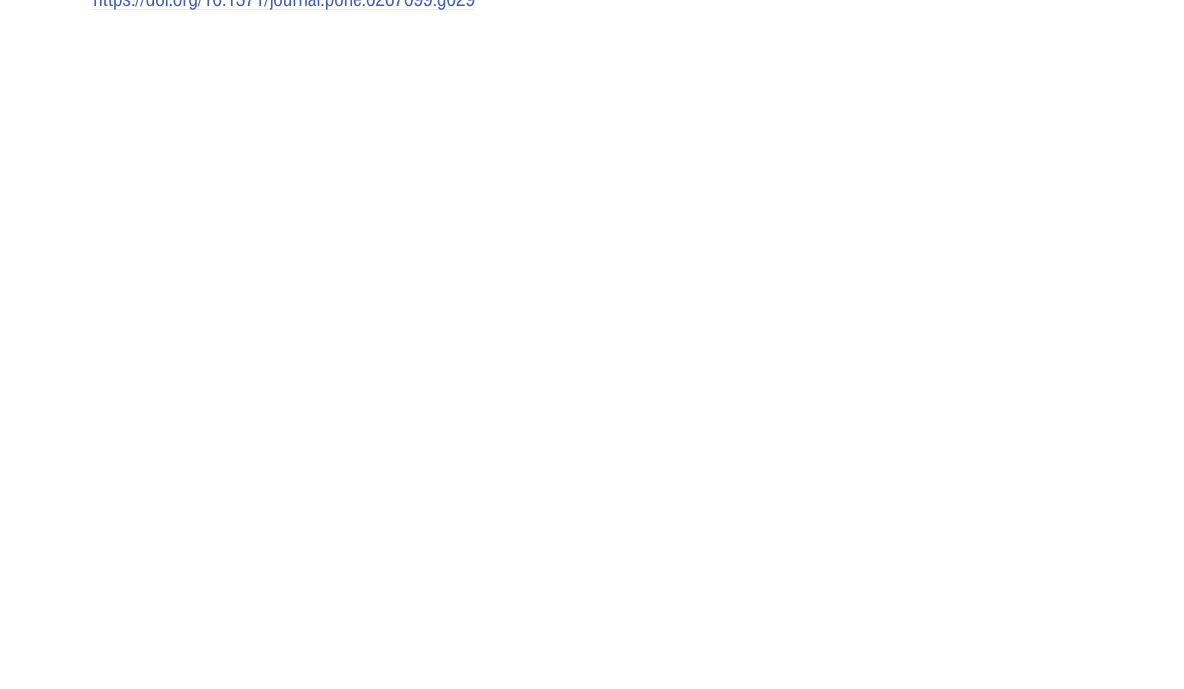
PLOS ONE | https://doi.org/10.1371/journal.pone.0267099 April 28,